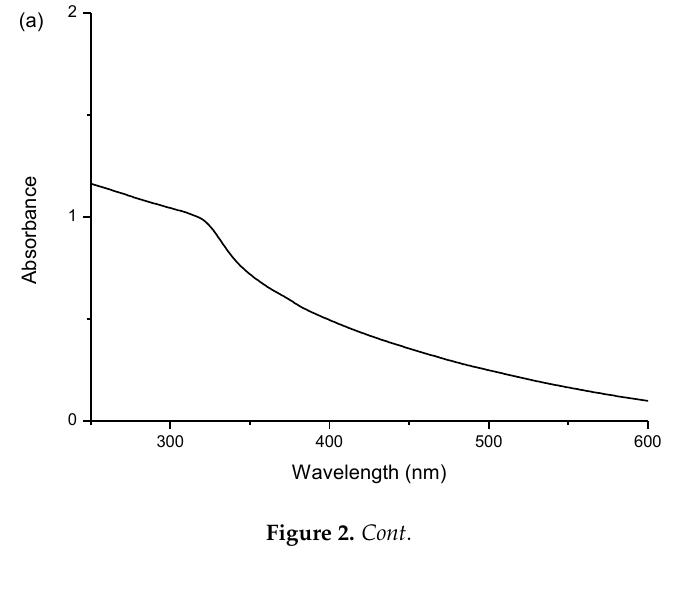
Figure 2. cont. Figure 2. Cont